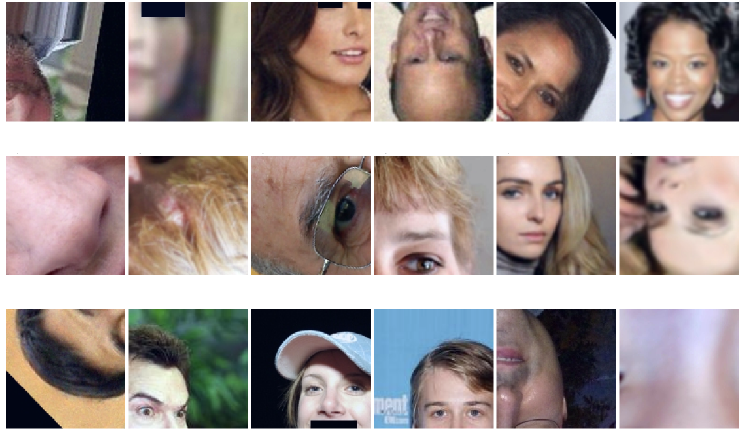
Figure 6. Sample output of random-crop with size 128 × 128.